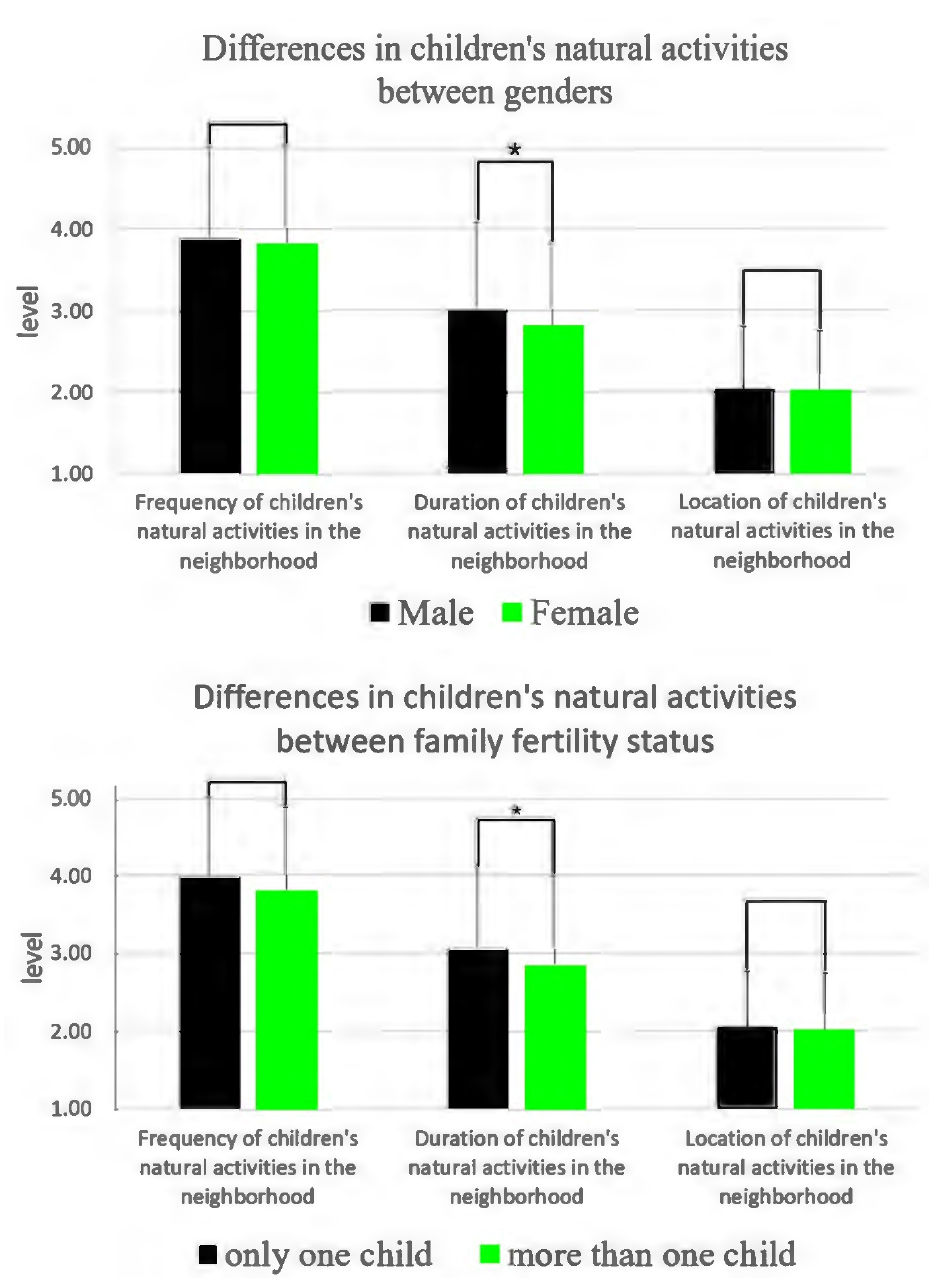
Figure 4. Differential description of children’s natural activities in the neighborhood; n = 26, mean ± SE, * p < 0.05, ** p < 0.01 determined by the paired t